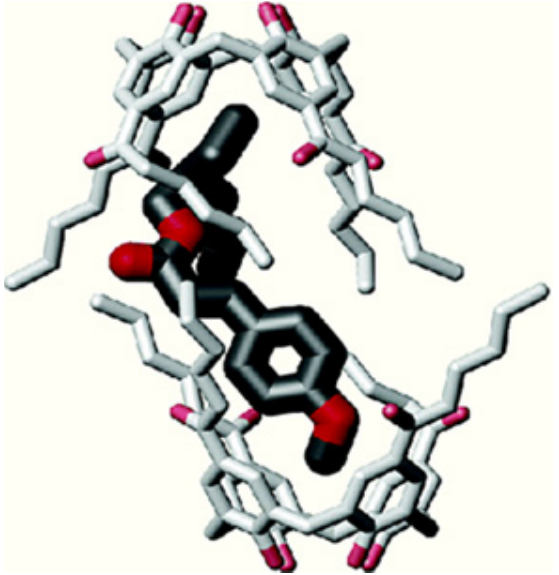
Figure 12. Capsular structure of inclusion complex of para -hexanoyl calix[4]-arene with t -EHMC (2* 2a . t -EHMC). Disorder and H-atoms are omitted for clarity